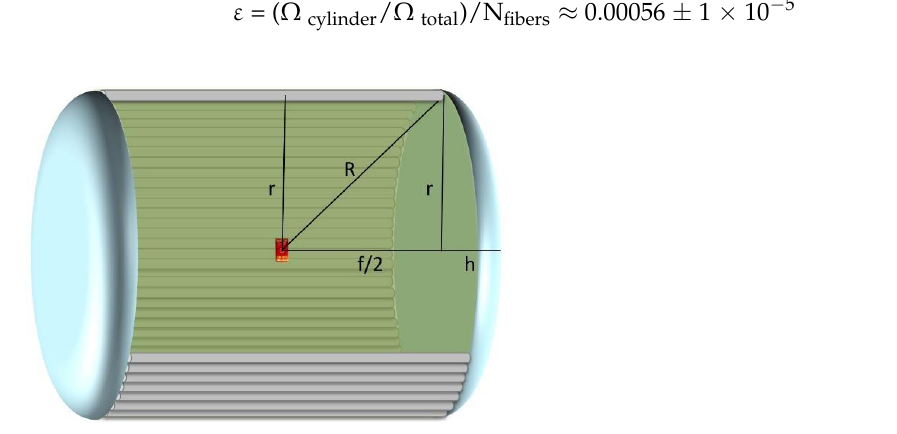
Figure 14. Sketch for the calculation of the geometrical efficiency of the SciFi detector in the setup of Figure 12. Figure 12.